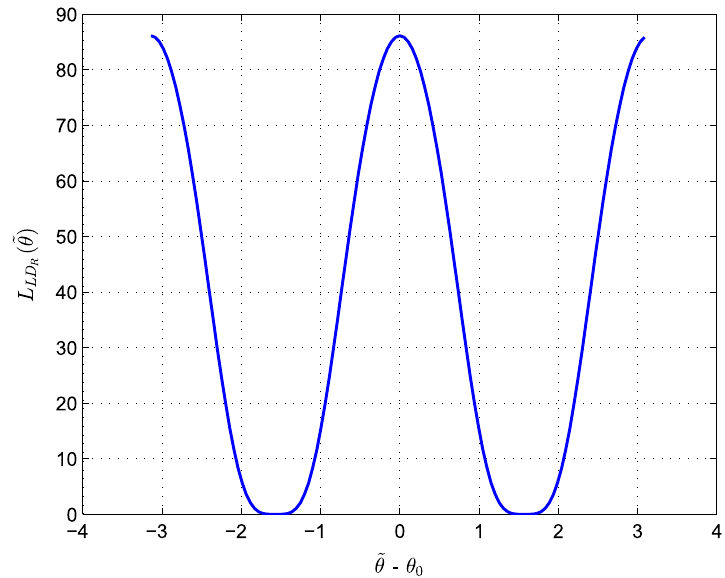
Fig. 1 L LD R ( ˜ θ) curve versus the phase offset estimation error ˜ θ − θ 0 in a noise-free channel